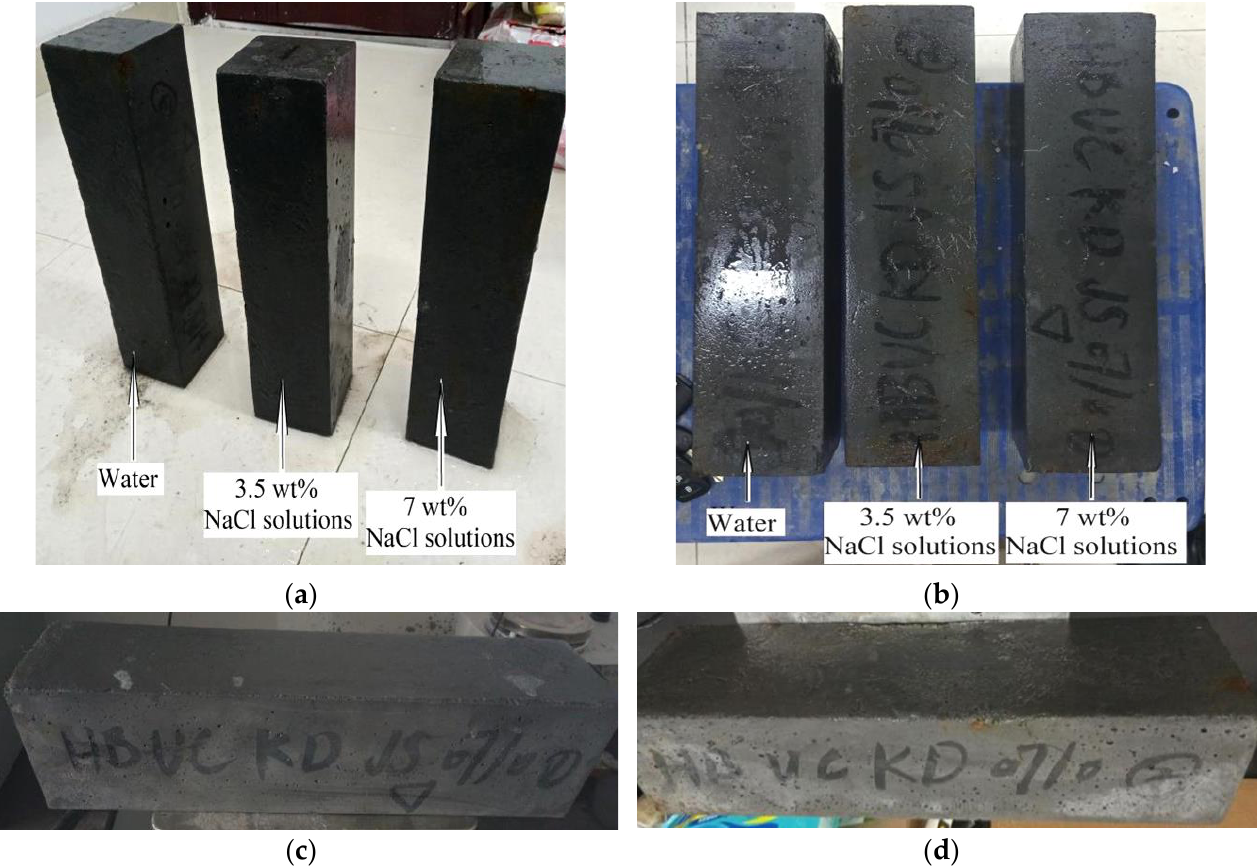
Figure 6. Comparison of SSUHPC/FEUHPC after freezing resistance testing: ( a ) SSUHPC in different solutions after testing; ( b ) FRUHPC in different solutions after testing; ( c ) Appearance of SSUHPC before testing; ( d ) Appearance of SSUHPC after testing in 7 wt% NaCl solutions.